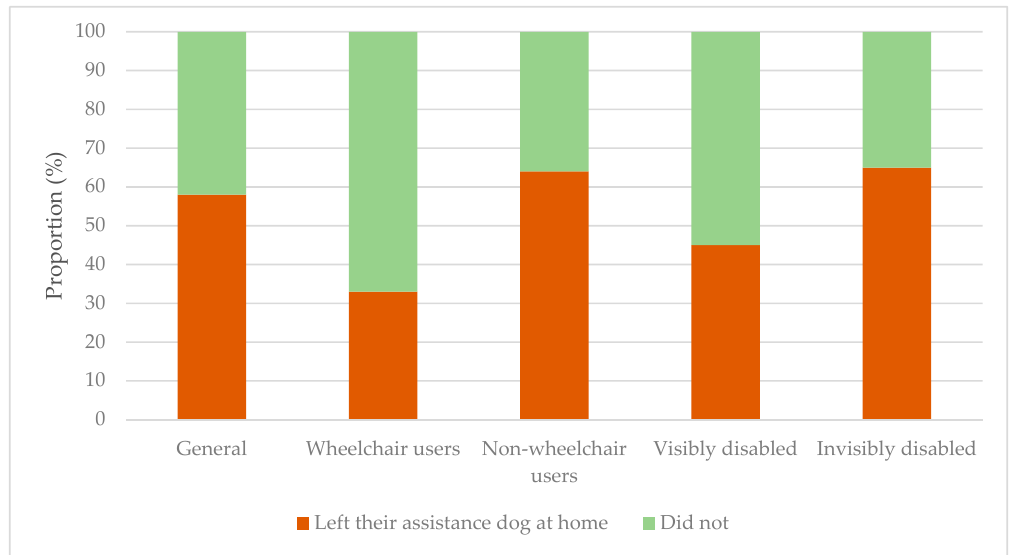
Figure 7. Proportions of participants who left their assistance dog at home because they felt that there was a low degree of acceptance for these dogs at certain places: in general and differentiated into subgroups.